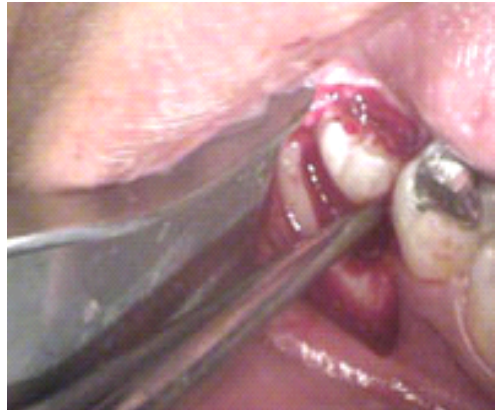
Figure (5): Surgical removal of impacted lower 3 rd molar (intra operative picture) The patient has been given 1 million i.u.